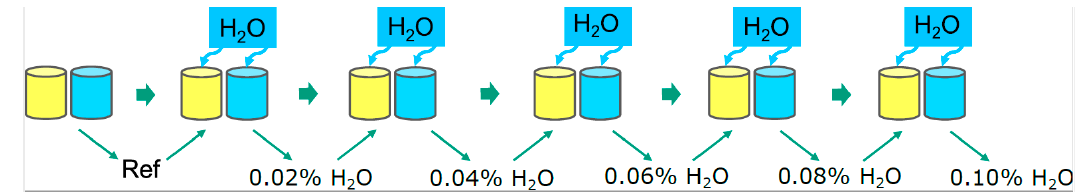
Figure 7. Order of water addition [6].